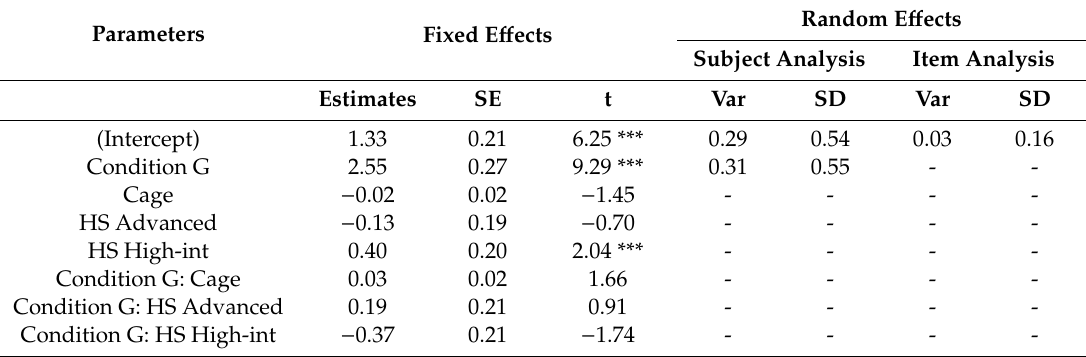
Table 3. Summary of the fixed e ff ects and random e ff ects in the mixed-e ff ects model (for the [-wh]